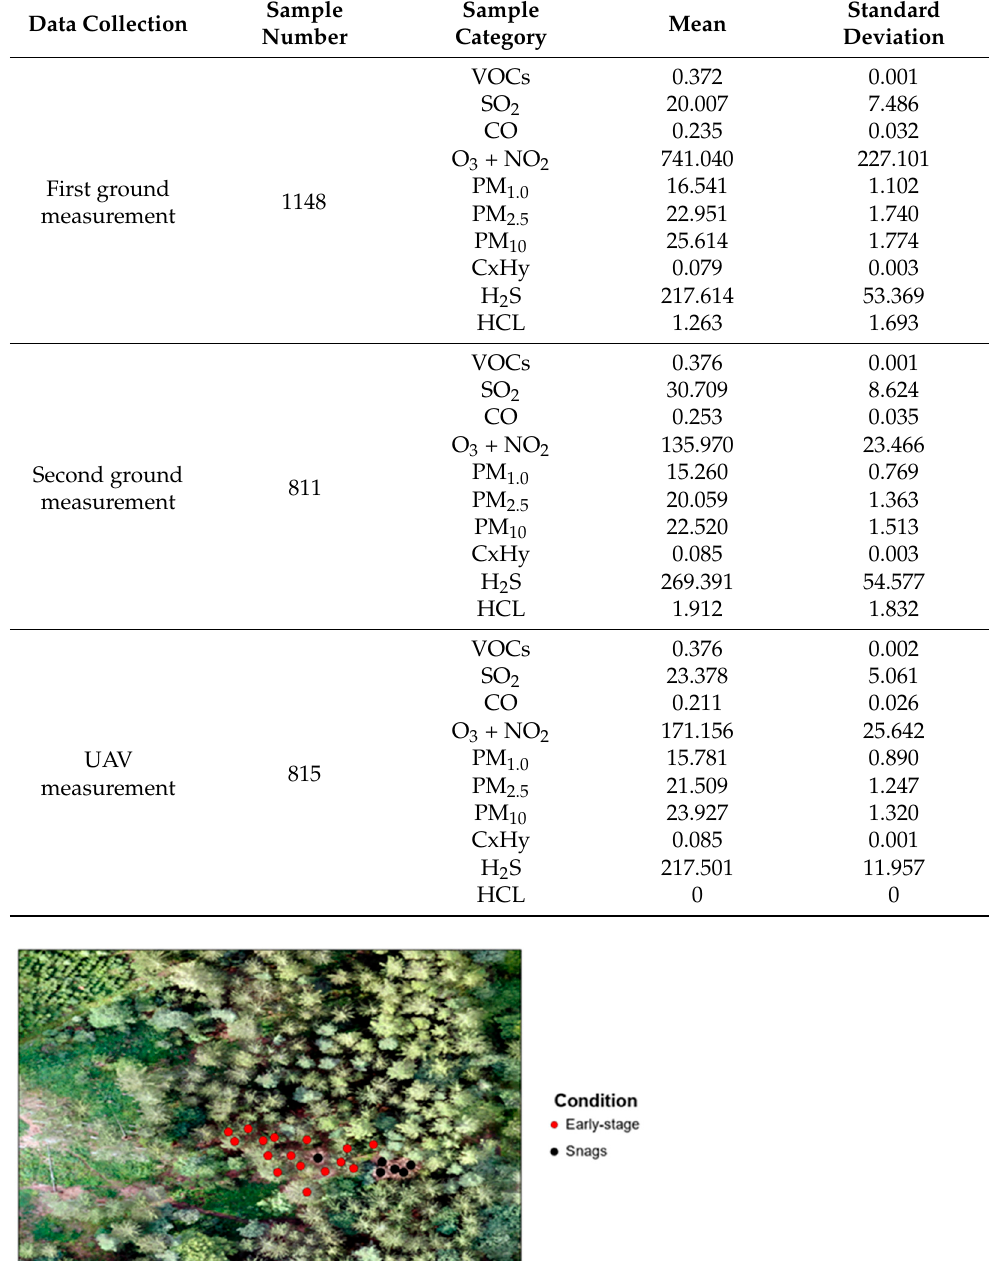
Table 1. Description of collected data, first ground collection, second ground collection, and UAV data collection.